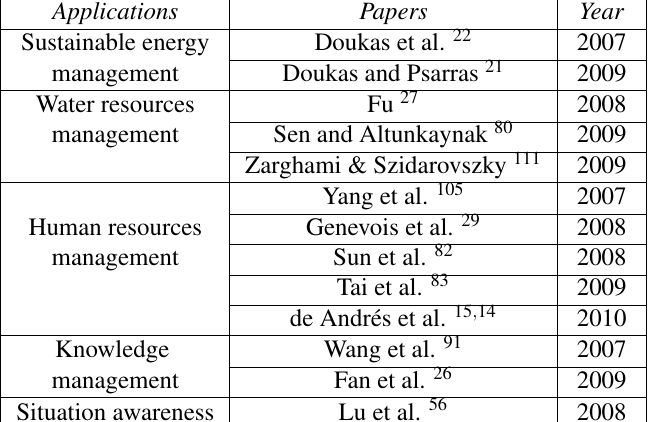
Table 3. Resource management linguistic based applications